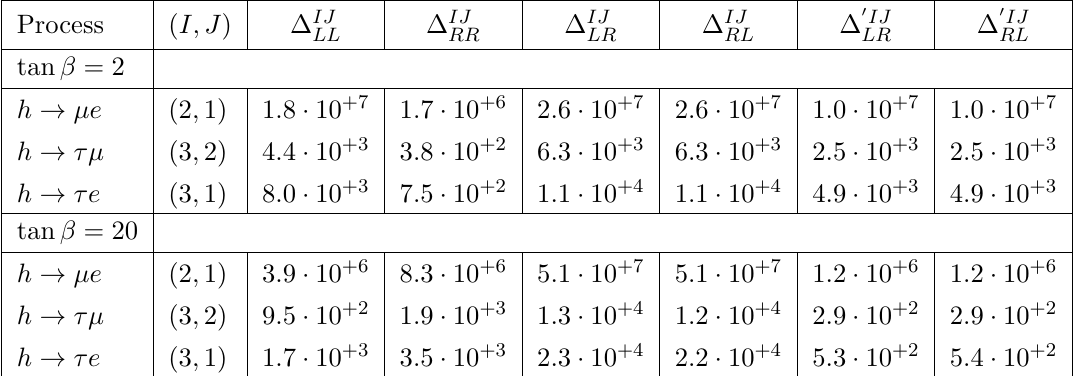
Table 5 . Ratios of upper bounds on the LFV (cid:1) parameters from leptonic Higgs boson decays and from radiative decays of charged leptons. The MSSM spectrum is de(cid:12)ned in eq. (5.3) (with the exception of setting A 0 II = 0) and a SUSY scale of M = 400 GeV. The ratios for (cid:1) IJ l